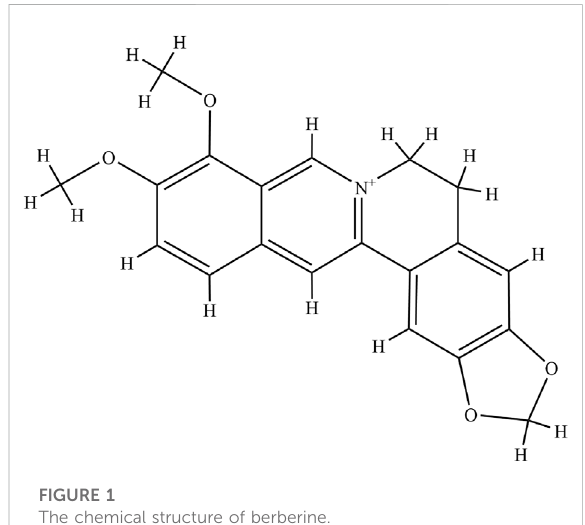
FIGURE 1 The chemical structure of